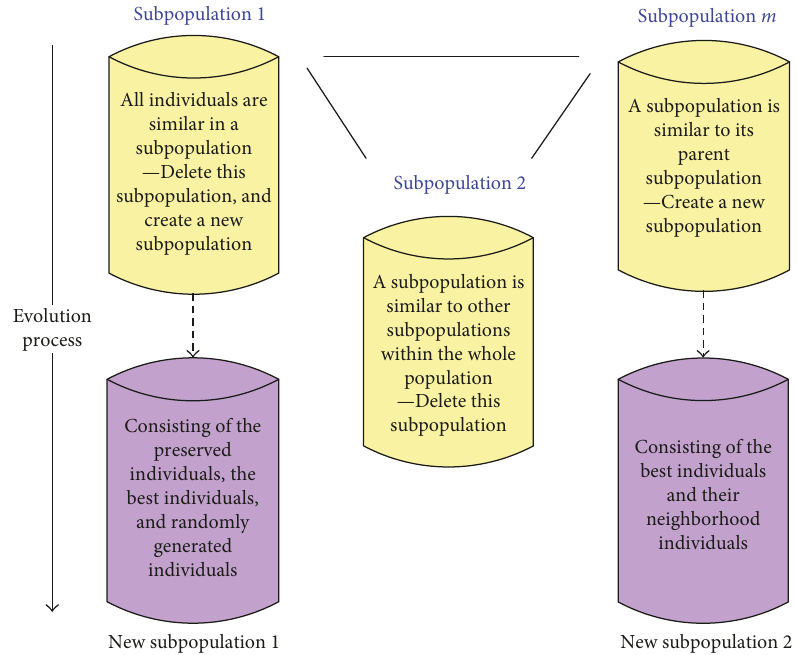
Figure 1: Multipopulation management strategy during evolution